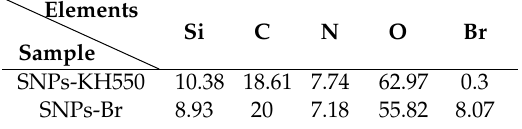
Table 1. The element compositions (atomic %) of SNPs-KH550 and SNPs-Br from